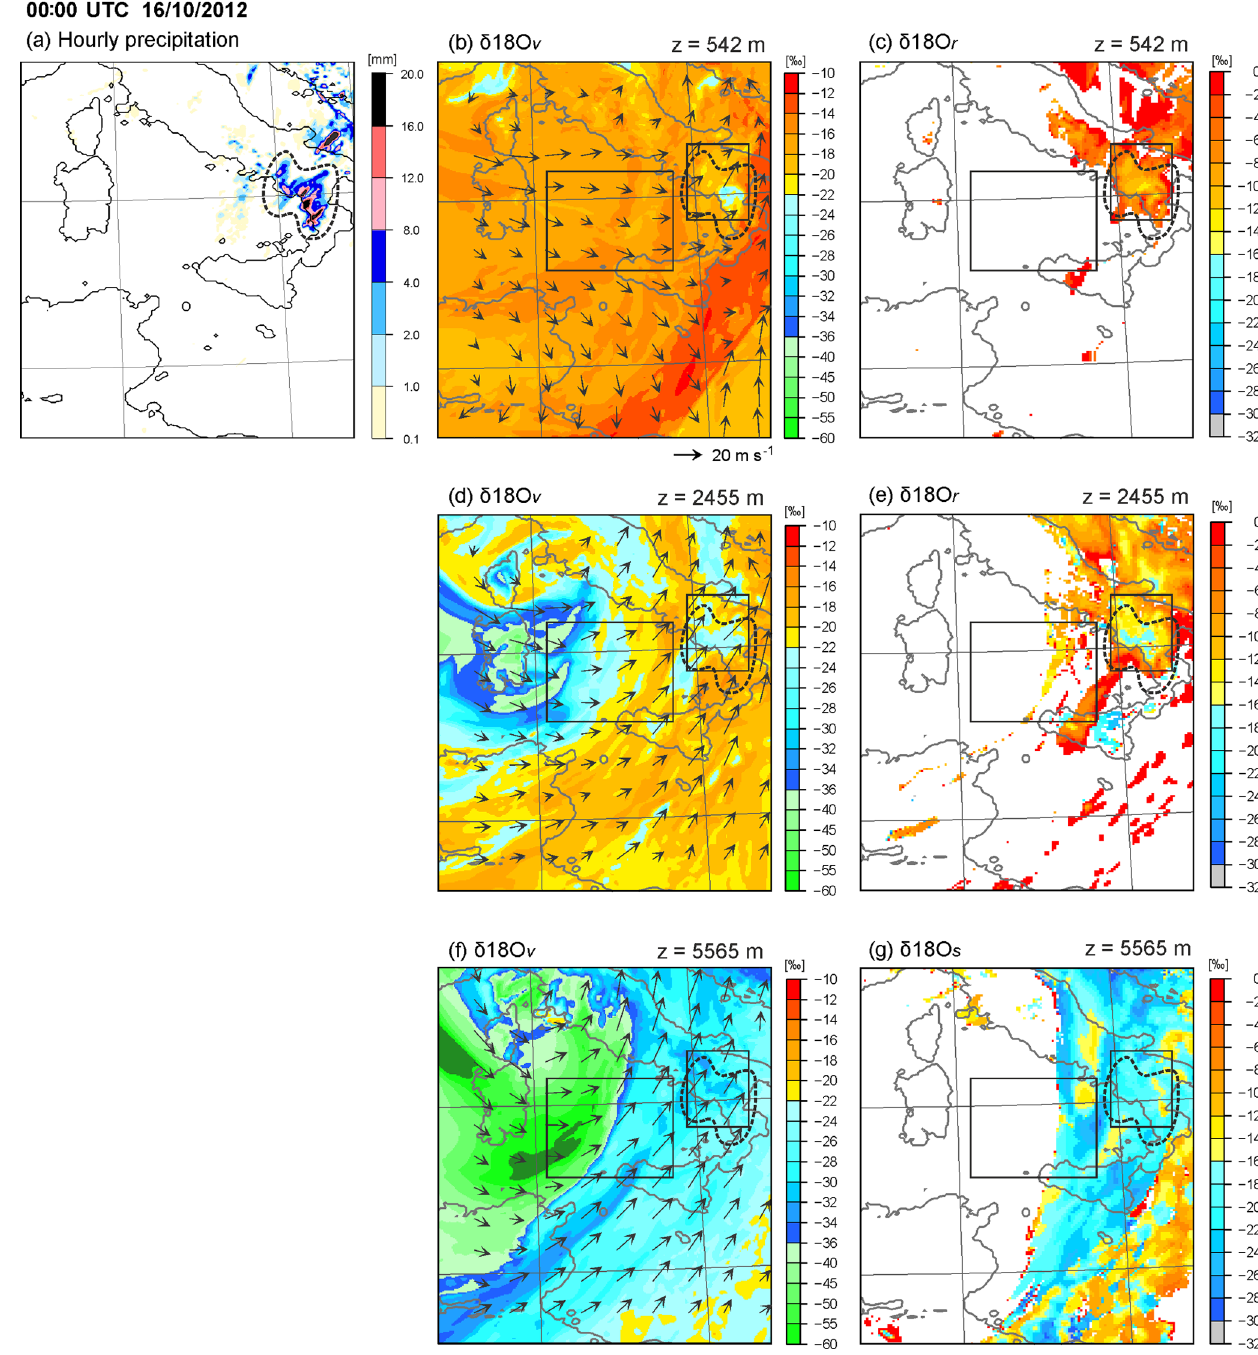
Figure 13. Same as Fig. 10 but for 00:00UTC on 16 October